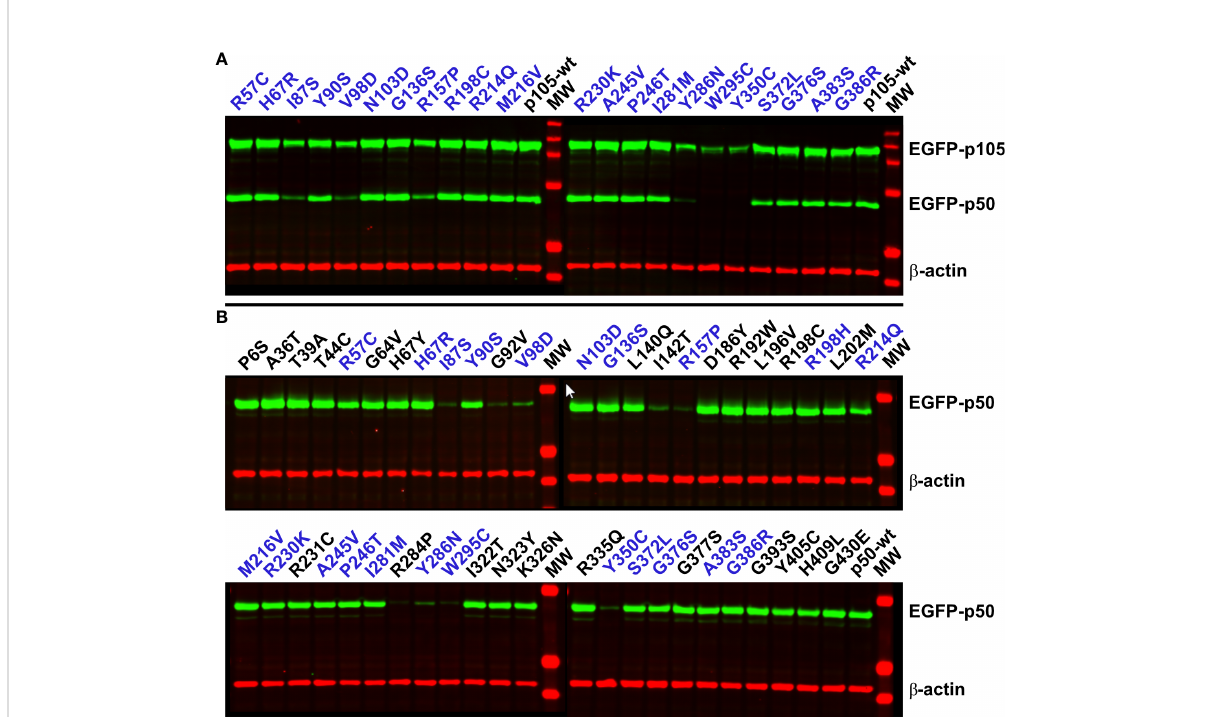
FIGURE 3 Damaging NFKB1 variants cause rapid p105 decay, abrogate processing of p105 to generate p50, and prohibit a sustained abundance of p50. HEK293T cells were transiently transfected with EGFP-fusion constructs either encoding p105 or p50 missense variants as indicated. Variants depicted in blue font were included in both panels. Whole-cell lysates were analyzed by Western blotting using antibodies directed against an epitope near the C-terminal end of p50, to simultaneously detect p105 and p50 (both green), and against b -actin (red) as loading control. (A) In cells transfected with wildtype p105 or non-decaying p105 mutants, an invariant proportion of the ectopically expressed p105 is converted to p50 by endogenous mechanisms. Deleterious variants are identi fi ed by weaker p105 expression and low or undetectable p50 (I87S, V98D, R157P, Y286N, W295C, and Y350C). Representative results of fi ve independent experiments are shown. (B) Upon enforced expression of p50 (skipping the precursor stage) deleterious variants only gain limited expression levels (I87S, G92V, V98D, I142T, R157P, R284P, Y286N, W295C and Y350C). Representative results of six independent experiments are shown. Samples were blotted once in two experiments and at least twice in four